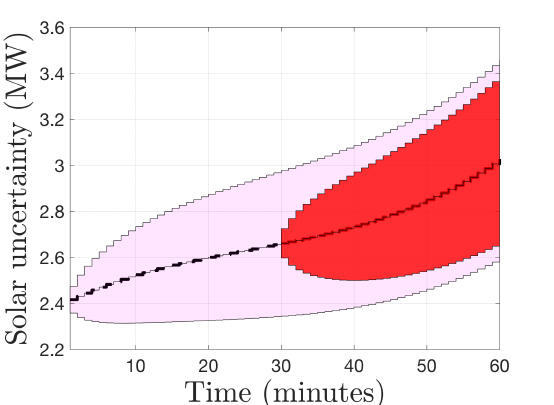
Figure 7. Illustrating the effect of the intra-hour forecast error model for solar PV forecast over the prediction horizon. The thick dashed line ( -- ) represent the expected solar PV generation. The forecasts provide a 60-minute preview window and are updated every 30